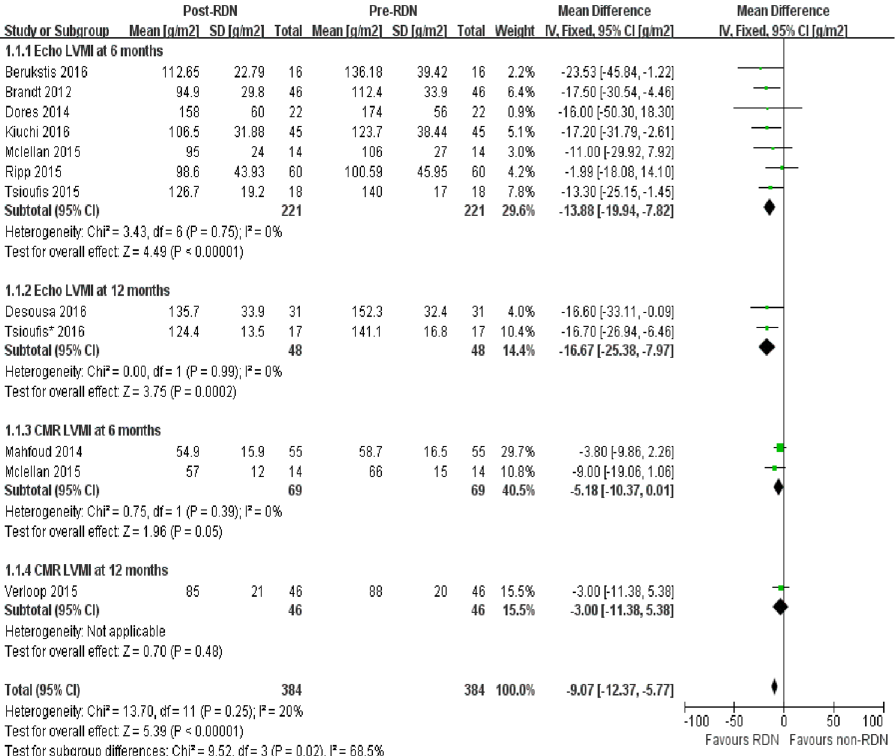
Figure 2. Forest plot of RDN changing LVMI in observational studies, stratified by follow up duration and imaging.